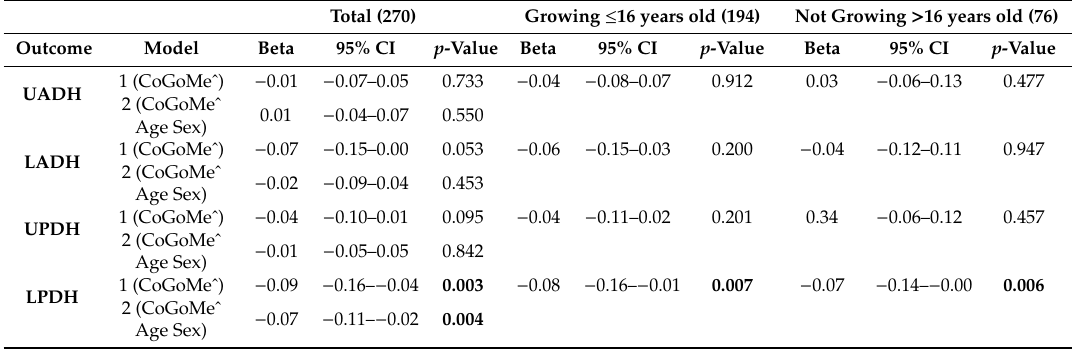
Table 4. Regression analysis between CoGoMeˆ and the di ff erent dentoalveolar heights.